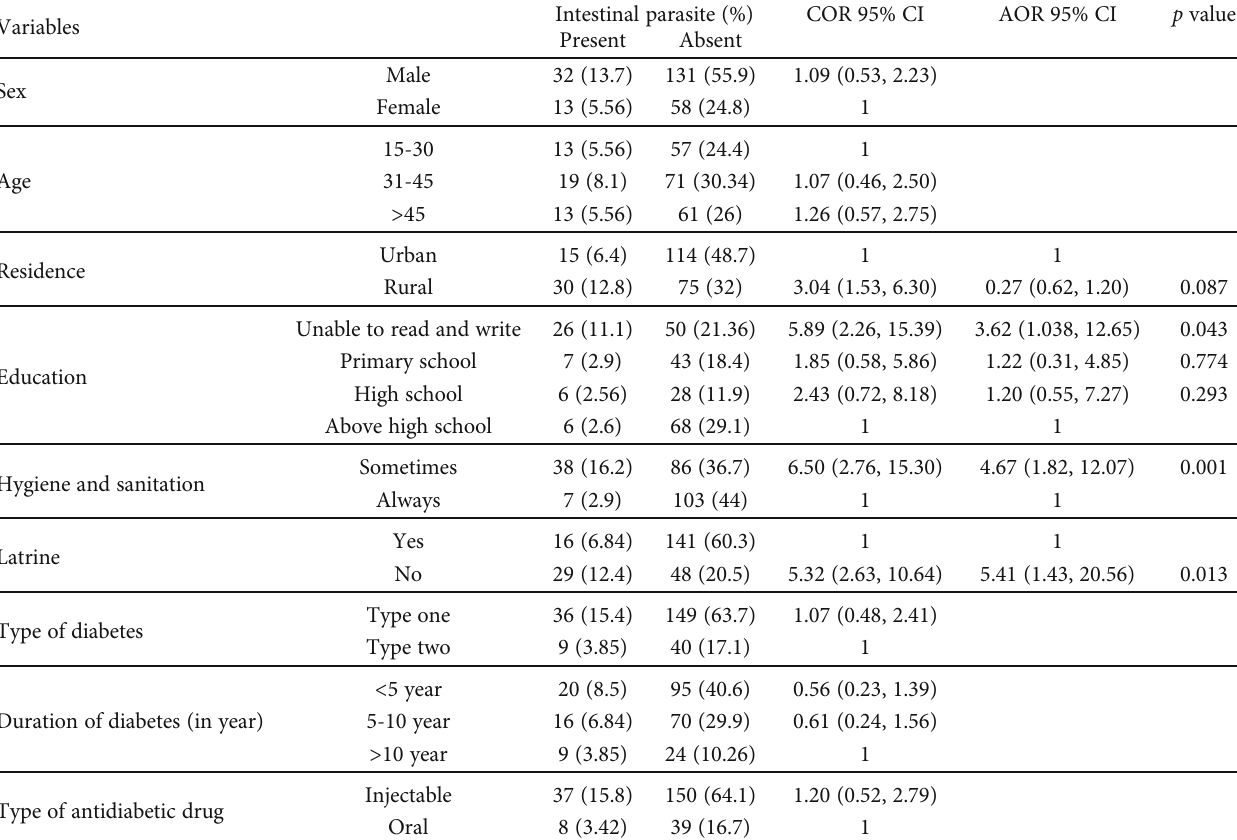
Figure 1: Type and frequency of intestinal parasites among diabetes mellitus patients at the University of Gondar Hospital, Gondar, Ethiopia, 2018. Table 2: Factors associated with intestinal parasitic infection among diabetic patients at the University of Gondar Hospital, Gondar, Ethiopia,